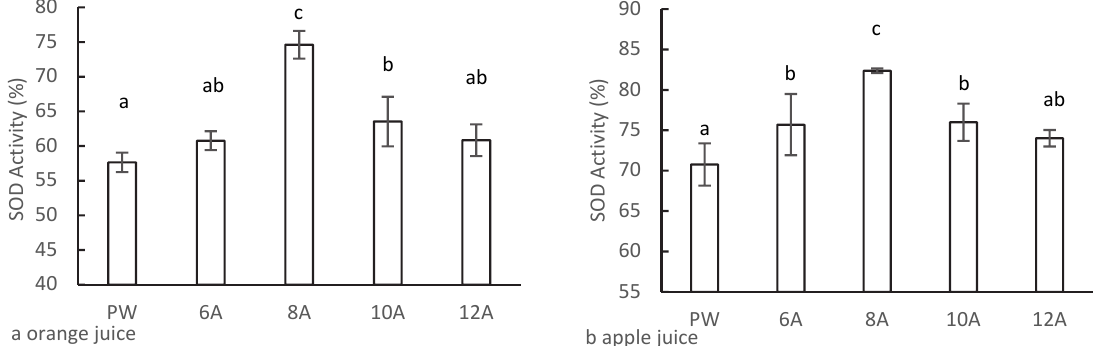
Figure 2. The effect of electrolysis current on SOD activity of AlEW 50% Tropicana juice; ( a ) orange juice; ( b ) apple juice. PW is pure water (control); 6~12A is the electrolysis current of AlEW. The different letters indicated significant difference ( p < 0.05).